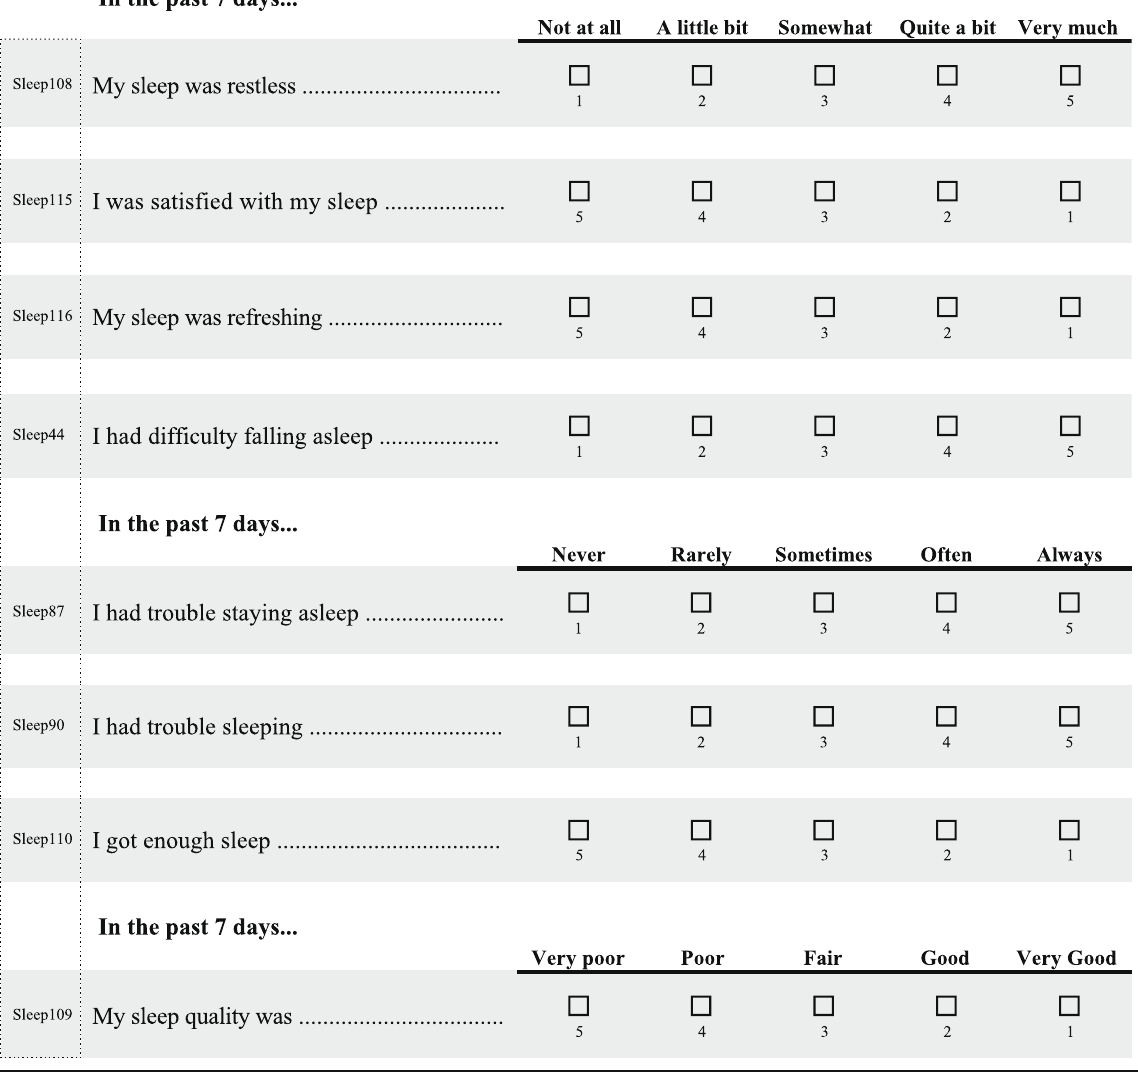
Table 2 PROMIS Sleep Disturbance Short Form 8b